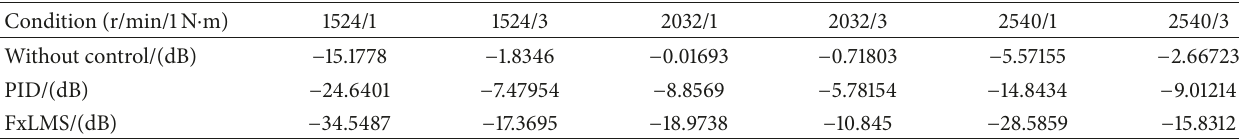
Table 5: The comparison results of Figure